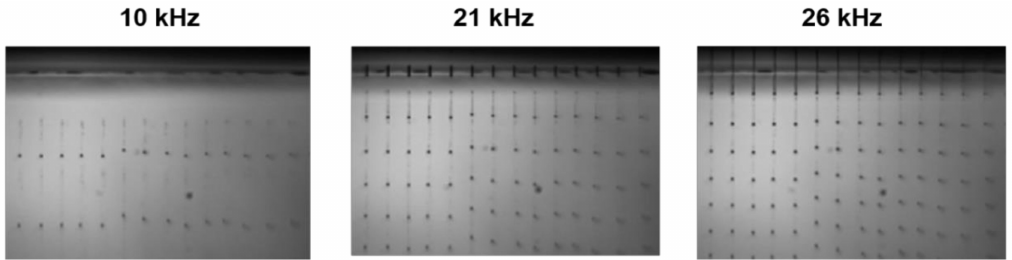
Figure 6. Jetting experiments of the solvent-based VIS-photochromic inkjet ink at 10, 21 and 26 kHz using an industrial inkjet printhead at 35 ◦ C.